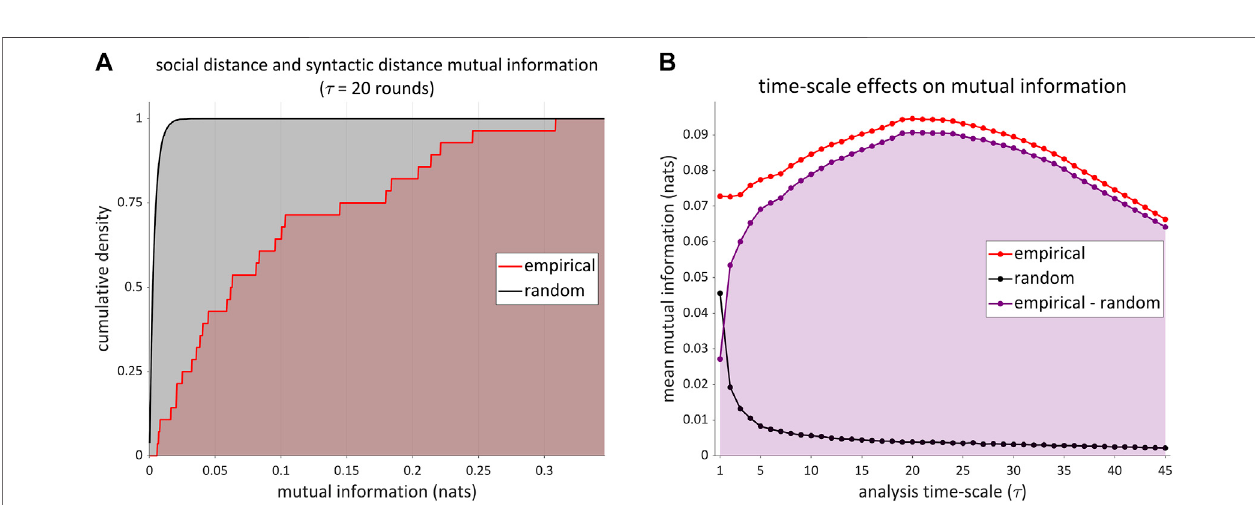
FIGURE 10 | Mutual information between social distance and syntactic distance time series. (A) Cumulative density of estimates of mutual information on a timescaleof τ =20rounds (redline);cumulativedensityofestimatesobtainedfromrandomlypermutedtimeseries(black line). (B) Meanmutualinformationasafunction of analysis timescale, along with the difference